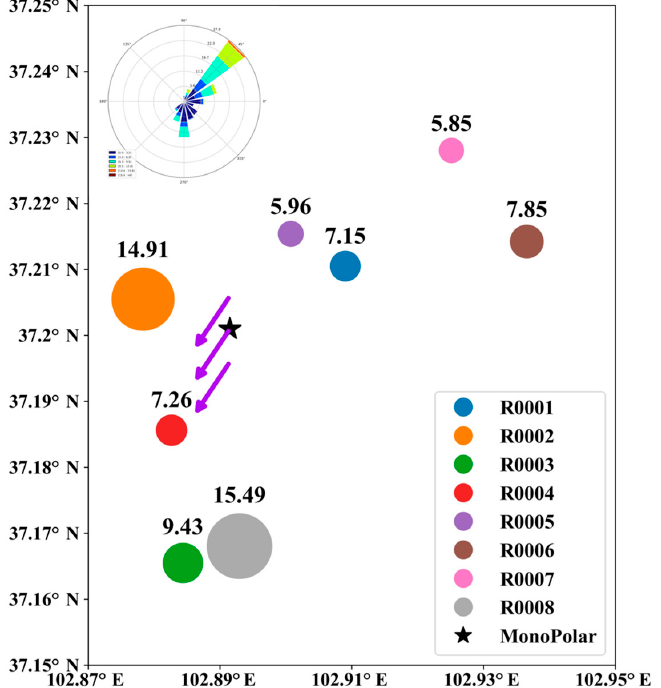
Figure 13. Wind and rain map at power-on in Wushaoling (21 September 2020). The direction of the arrow in the figure indicates the wind direction, and the upper left corner of the figure is the wind rose diagram.